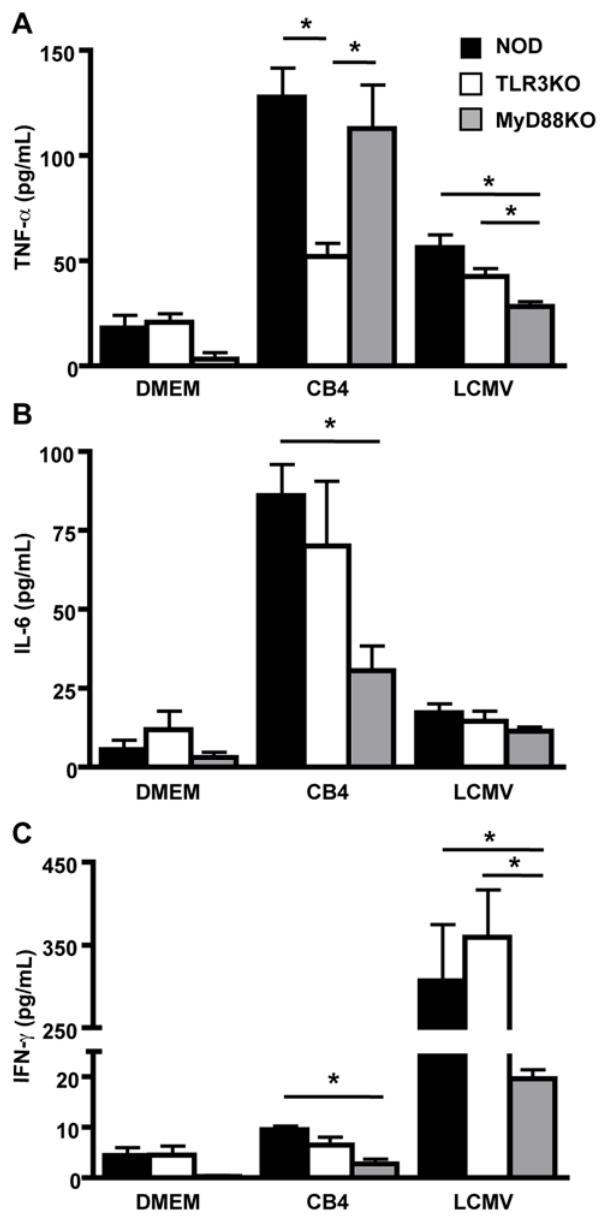
Figure 5. TLR3 deficiency results in reduced production of TNF- a following CB4 infection. Serum levels of A) TNF- a , B) IL-6 and C) IFN- c from WT NOD (black bars), TLR3KO (white bars) and MyD88KO (grey bars) mice were measured with a CBA inflammation kit 4 days following infection with 400 pfu of CB4, 1 6 10 5 pfu of LCMV or mock- infection with DMEM. N= at least 3 for DMEM and LCMV treatments and n= at least 5 mice for CB4 treatments. Pooled data from at least 2 independent experiments are presented as mean + / 2 s.e.m. Stars denote statistical significance.